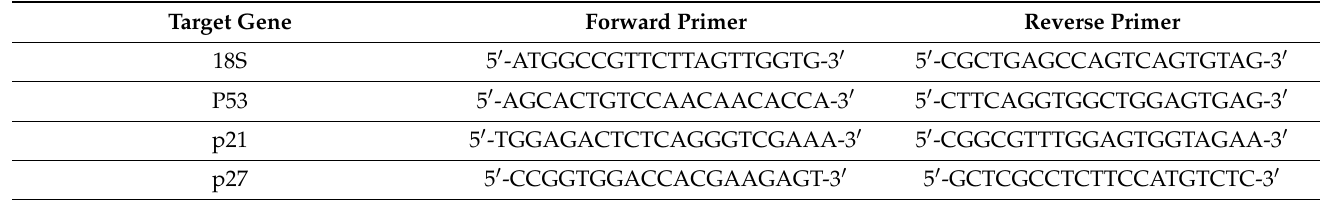
Table 1. Target genes and terminal primers used in the RT-qPCR